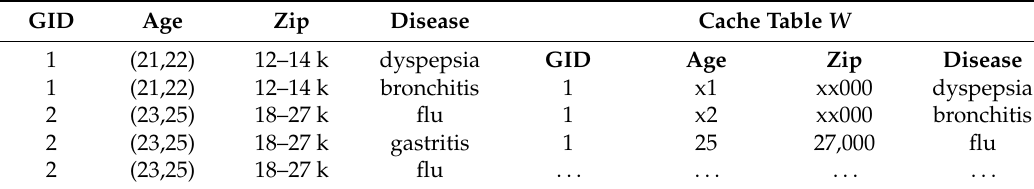
Table 4. The equivalent group and the cache table W (when t1 is